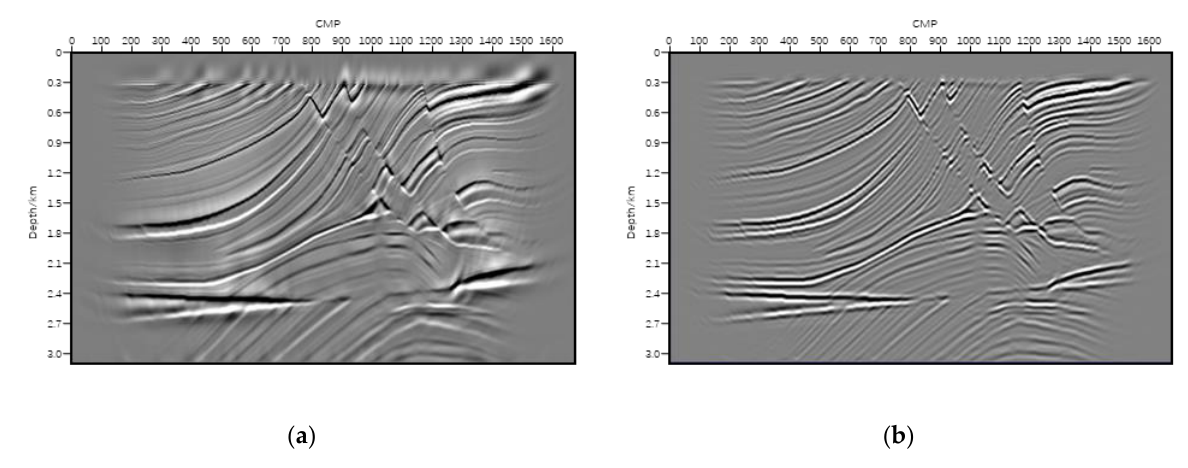
Figure 2. Results from LSM in imaging domain by using single point spread function. ( a ) the point spread function at grid (26, 1), the shallow details are similar as reflectivity model; ( b ) the point spread function at grid (26, 11), the image is much closer to RTM result.